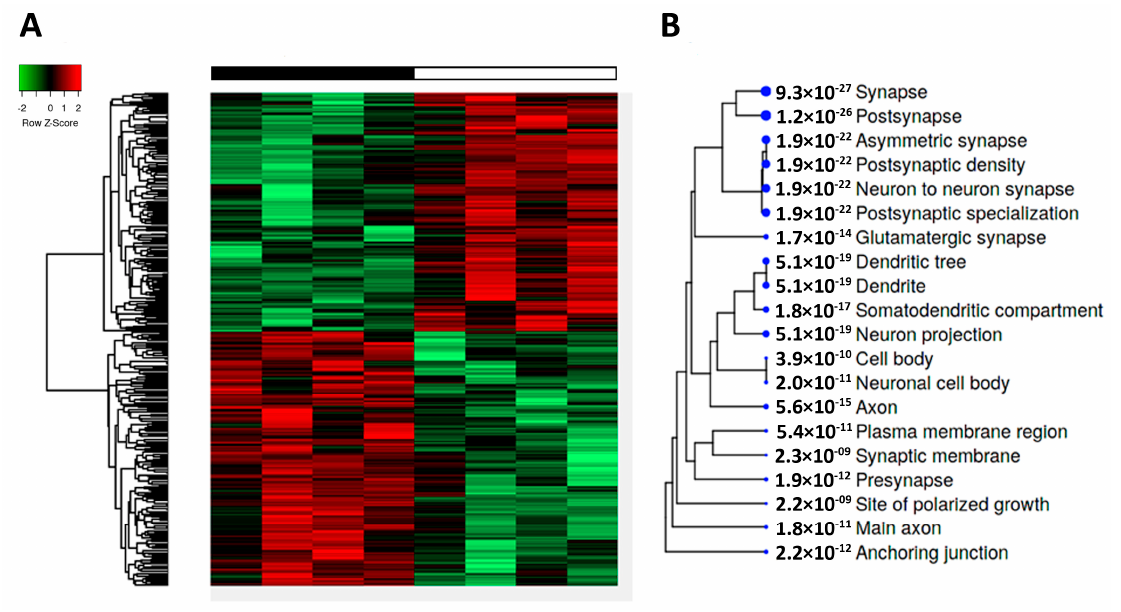
Figure 4. ( A ) A heatmap of the cerebral cortex’s phosphoproteome shows 121 hypophosphorylated and 98 hyperphosphorylated proteins. ( B ) The altered phosphoproteome in tau-KO mice mainly affects synapses, axons, dendrites, and the neuronal cell body. Sample legend in the heat-map plot: white boxes correspond to wild-type animals, and black boxes correspond to tau-KO animals. The blue dot size beneath each gene cellular component category is proportional to the enrichment FDR score number (between dot and category name) obtained from the differentially expressed proteins involved in the functional group.